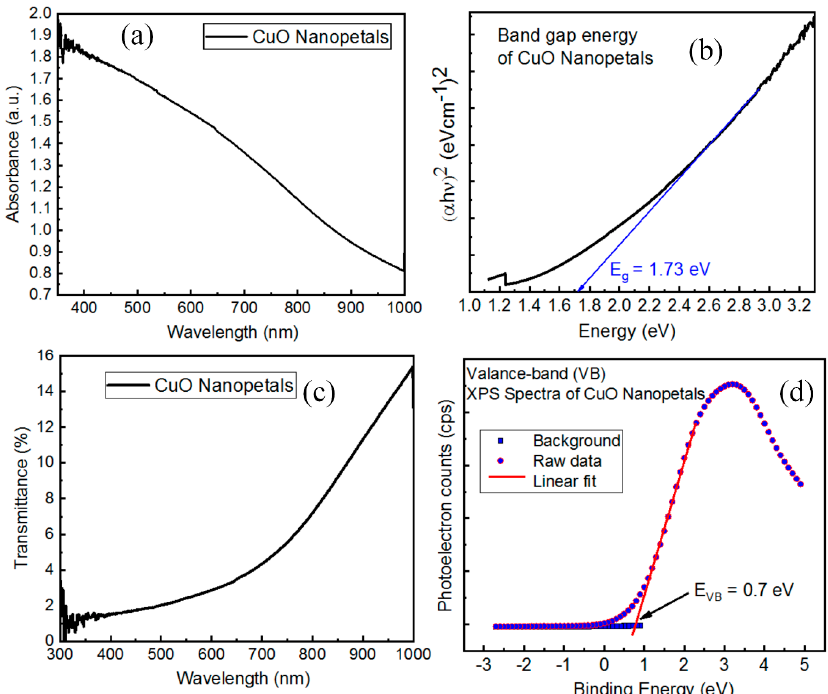
Figure 7. Optical study of CuO petal-like nanostructure. ( a ) UV–VIS absorption spectrum. ( b ) Band gap energy of CuO nanopetals. ( c ) Transmittance spectrum. ( d ) XPS wide spectrum plot for valance band (VB) calculation of CuO nanopetals.